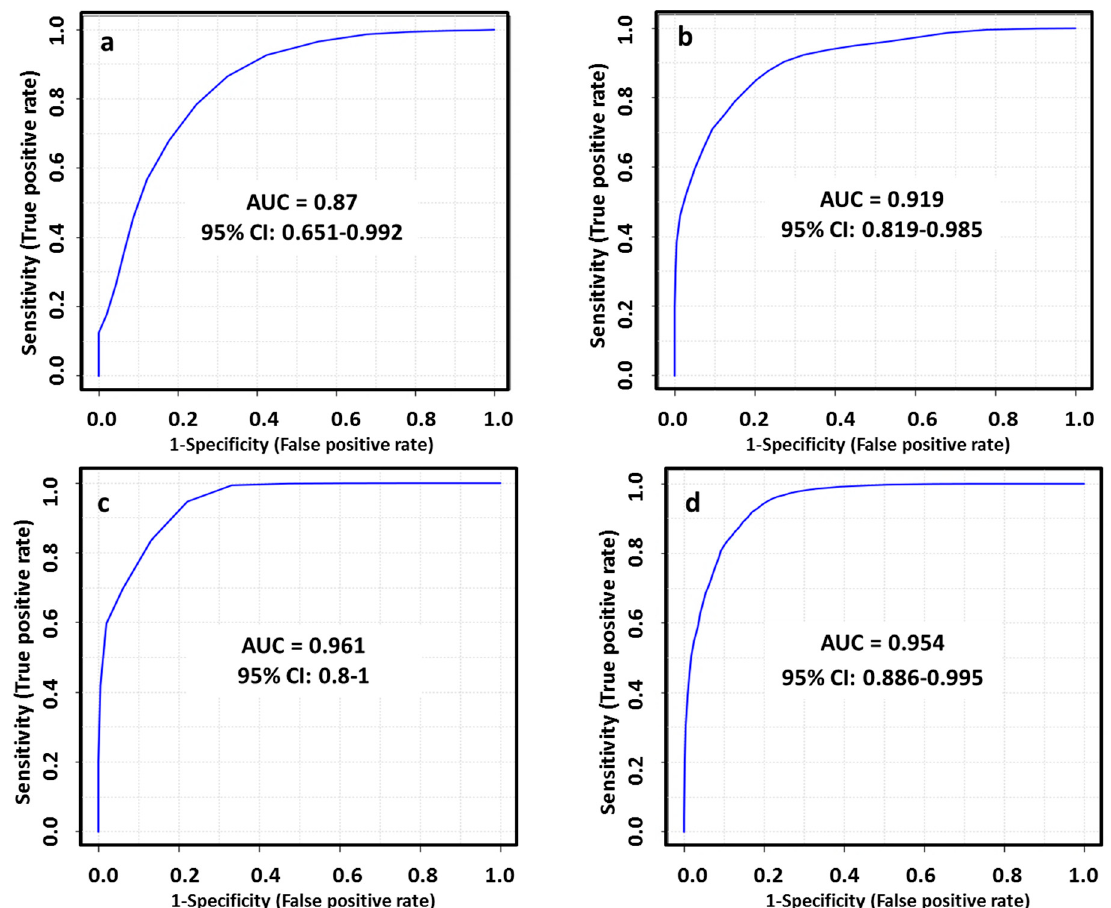
Figure 5. ROC curves for combined biomarkers model in LA_BC ( a ), HER2_BC ( b ), TN_BC ( c ) and LB_BC ( d ) by ESI+ and ESI − ; 100 cross-validations were performed, and the results were averaged to generate the plot.